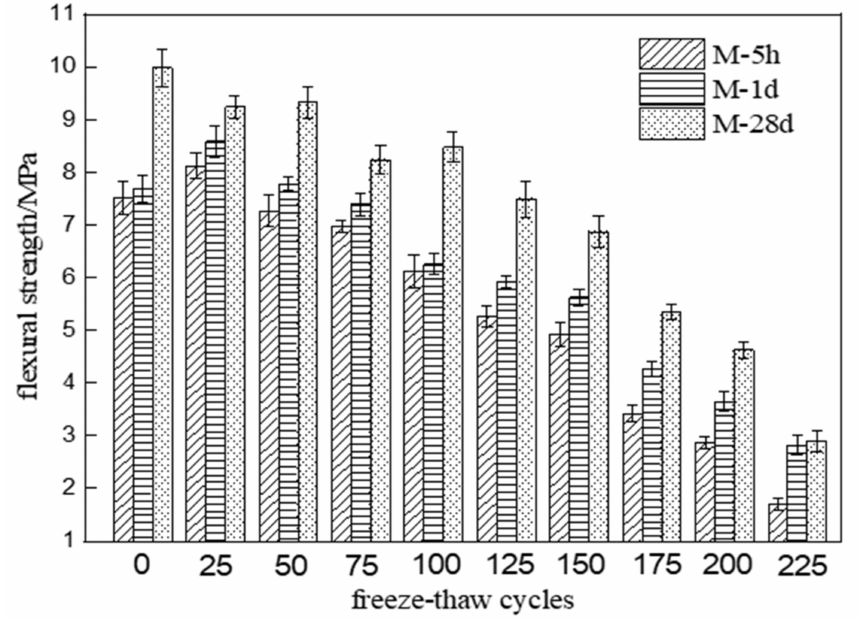
Figure 1. Flexural strength changes of MKPC mortar specimens with the number of freeze–thaw cycles in water (M-5h, M-1d, and M-28 refer to MKPC mortar specimens at hydration ages of 5 h, 1 d, and 28 d,